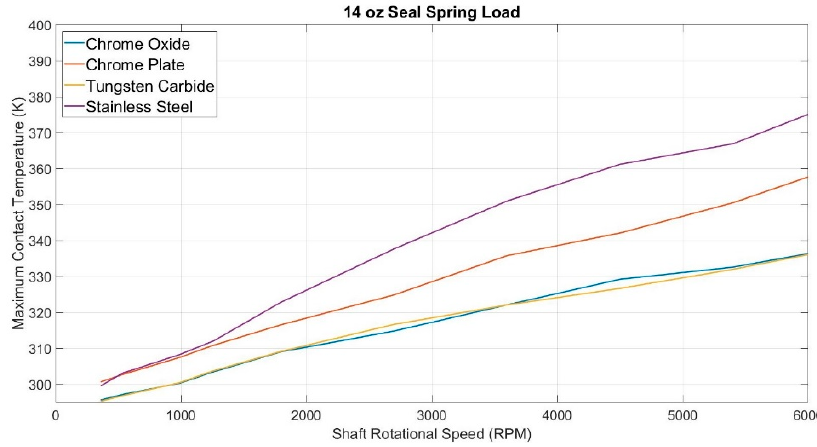
Figure 10. Maximum contact temperature at sealing interface for all 14 oz spring loads, comparing temperatures reached for CO, CP, TC and SS sleeves.